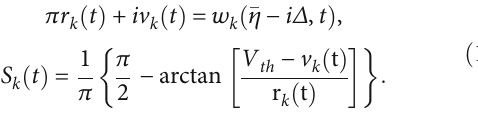
when J = 12 (a) and J when I = 5 (b). The blue solid lines ext ext e e